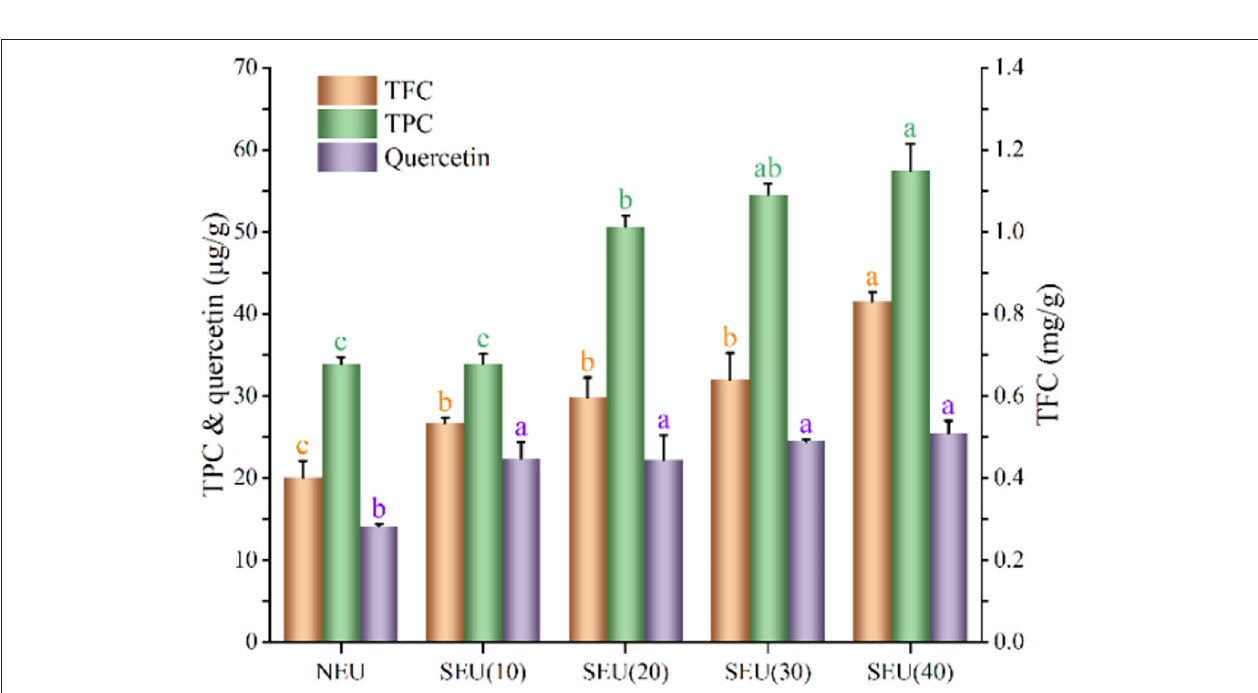
FIGURE 2 | Effect of steam explosion on bioactive compounds of Eucommia ulmoides Oliver bark. TFC, total flavonoids content; TPC, total phenolics content; NEU, native Eucommia ulmoides Oliver bark; SEU, steam-exploded Eucommia ulmoides Oliver bark, SEU(10) to SEU(40) indicated steam explosion retention time was 10–40min, respectively. (Means that do not share a letter are significantly different, p < 0.05). Different letters in data bars represent significant differences at p < 0.05 as determined by Duncan’s multiple range test.